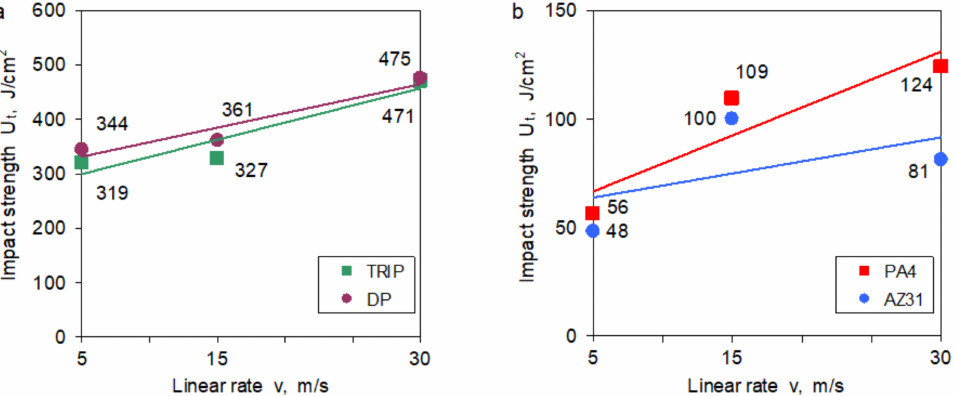
Figure 10. The impact strength as a function of the linear rate of the impact hammer for: ( a ) TRIP and DP steels and ( b ) PA4 and AZ31